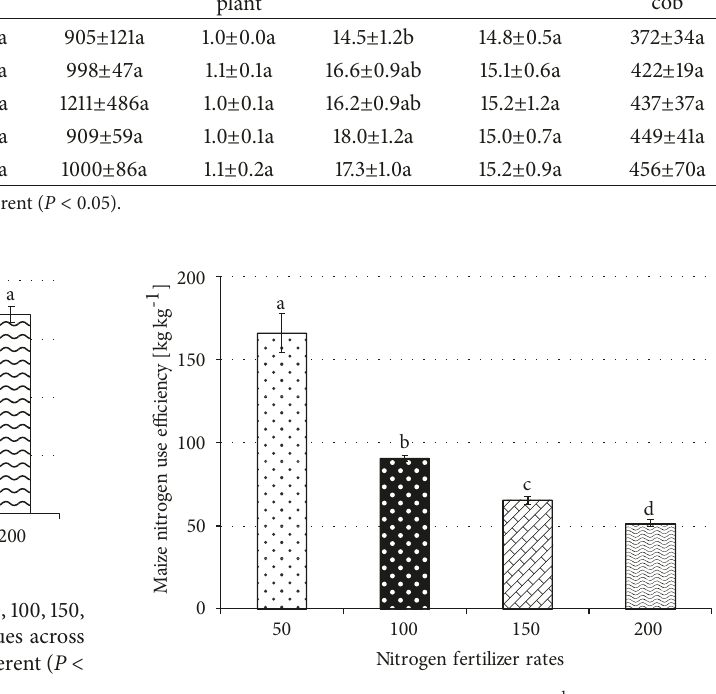
Figure 4: Maize nitrogen use efficiency (kg kg −1 ± SD) assessed by the Nitrogen-Partial Factor Productivity (N-PFP) across nitrogen fertilizer rates (50, 100, 150, and 200 kg ha −1 ). Values across N fertilizer rates with different letters are significantly different ( P <